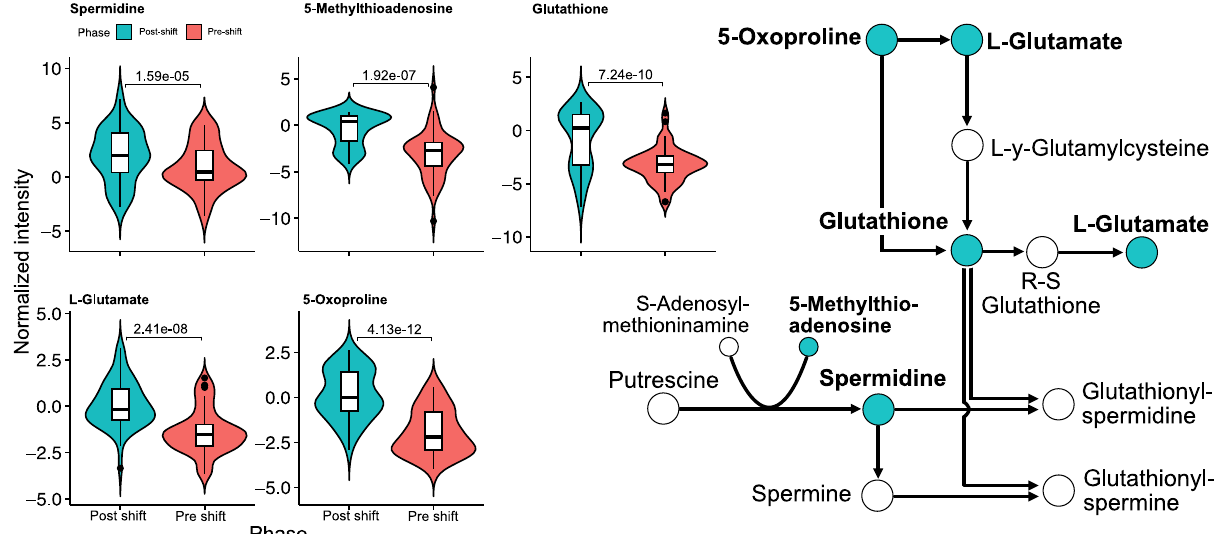
Fig. 3 Reduced metabolic network showcasing the intersection between glutathione metabolism and arginine and proline metabolism. Highlighted metabolites are signi fi cantly accumulated over the course of the phase change as seen in the violin plots ( p -values from the linear model). Non-highlighted metabolites were not identi fi ed in the data set. In the boxplots, the center lines represent the median; box limits represent upper and lower quartiles; whiskers extend to the fi rst or last data point that is within 1.5× the interquartile range of the box limits in the lower and upper directions respectively. Dots are values outside of 1.5× interquartile range beyond either end of the